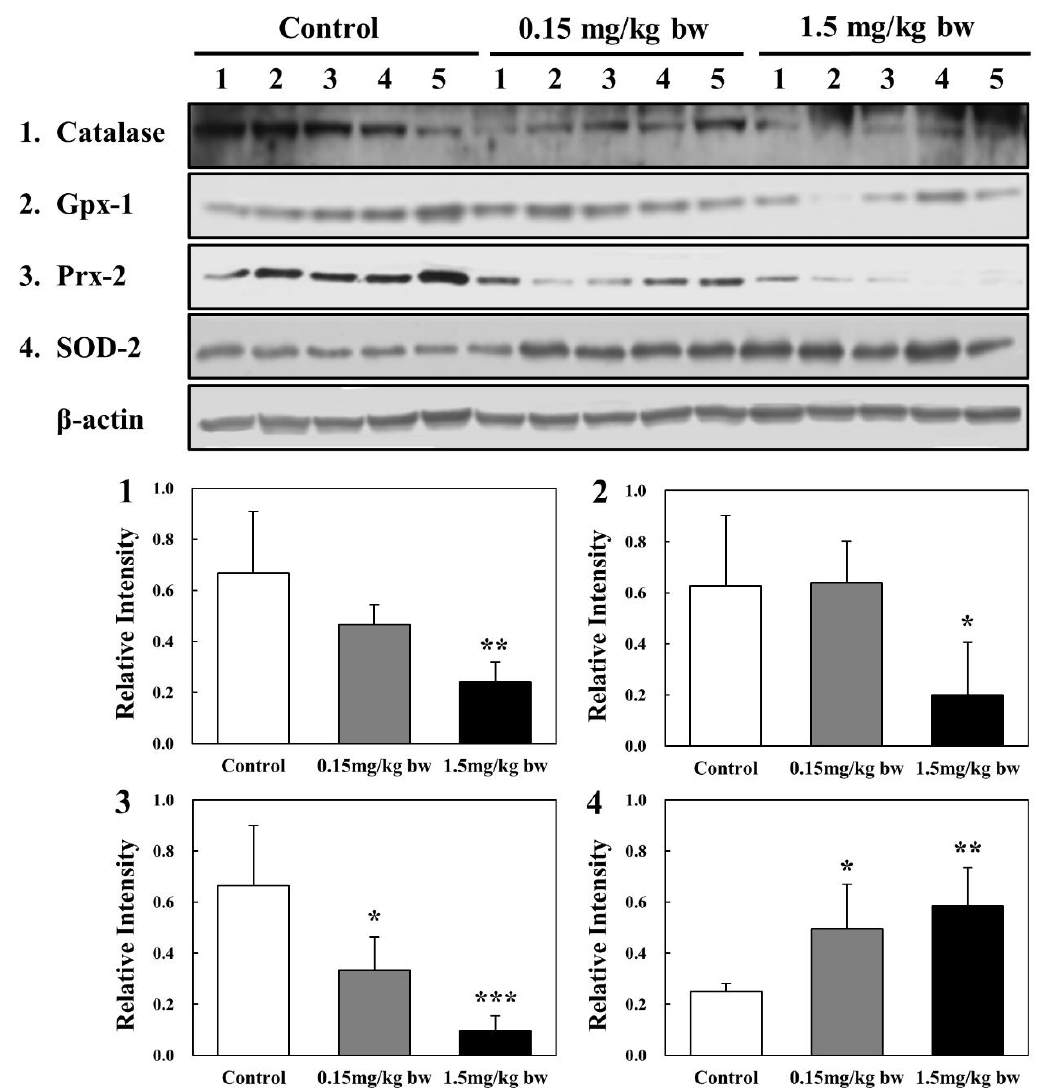
Figure 5. Western blot analysis of antioxidant enzymes in rat lung tissues: ( 1 ) catalase; ( 2 ) Gpx-1; ( 3 ) Prx-2; and ( 4 ) SOD-2. Amounts represented by the gel bands are expressed as intensity relative to β -actin. All relative intensities are presented as means ± SD of five experiments; *, **, and *** indicate p -values of 0.05, 0.01, and 0.001, respectively, compared with the control.